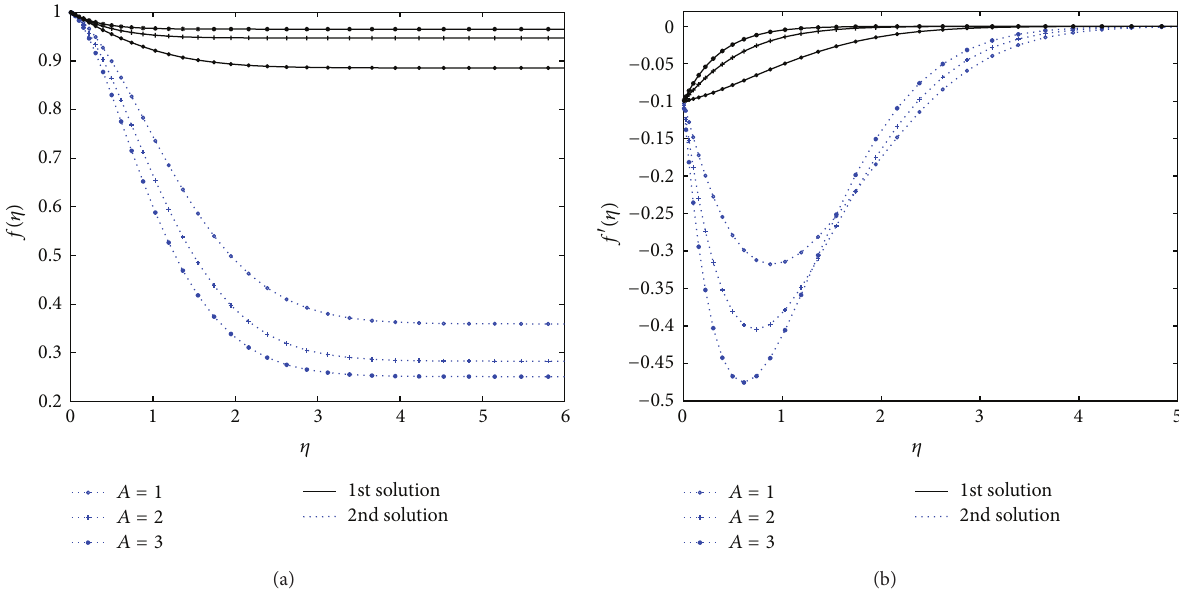
Figure 5: Variation of velocity profiles (a) 𝑓(𝜂) and (b) 𝑓 󸀠 (𝜂) for various values of 𝐴 when 𝜆 = −0.1 , 𝑠 = 1 .